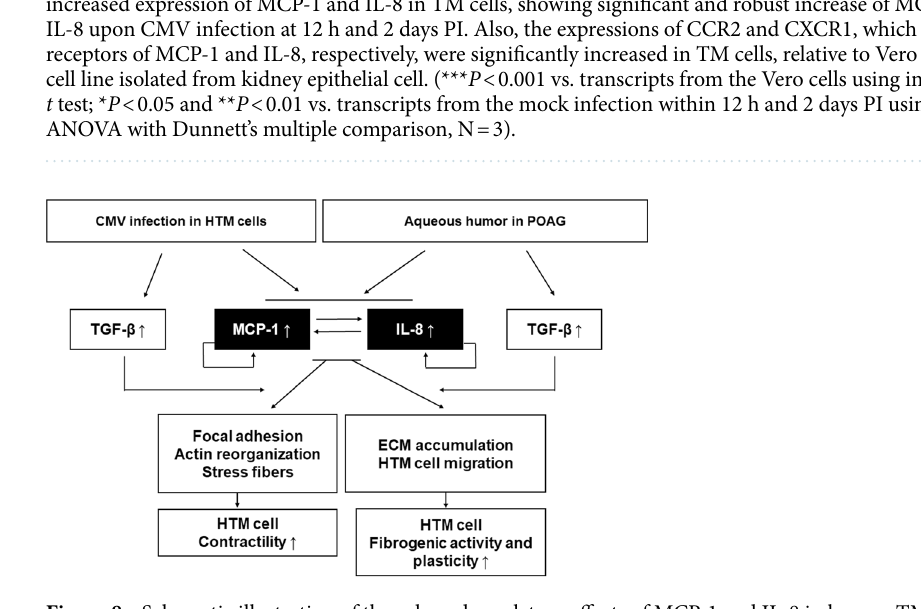
Figure 8. Schematic illustration of the role and regulatory effects of MCP-1 and IL-8 in human TM cells. CMV or HSV-1 infection in human TM cells dramatically increases the expression of inflammatory chemokines MCP-1 and IL-8 as well as TGF-β, which is also increased in the aqueous humor of primary open angle glaucoma (POAG). TM cells express the receptors of MCP-1 and IL-8 (CCR2 and CXCR1, respectively), and MCP-1 and IL-8 are augmented in an autocrine manner, and exhibited reciprocal regulatory effects on each other, while TGF-β inhibited the expression of MCP-1 and IL-8. Short-term treatment with MCP-1 and IL-8 increases the focal adhesion, actin reorganization, and stress fibers via Rho-A pathway, which collectively increases TM cell contractibility. Long-term treatment with MCP-1 and IL-8 enhanced EMT markers, ECM accumulation and TM cell migration, indicating increased fibrogenic activity and cell plasticity. This short term and long-term effects of inflammatory chemokines might contribute to the increased resistance to the aqueous humor outflow facility in hypertensive anterior uveitis and